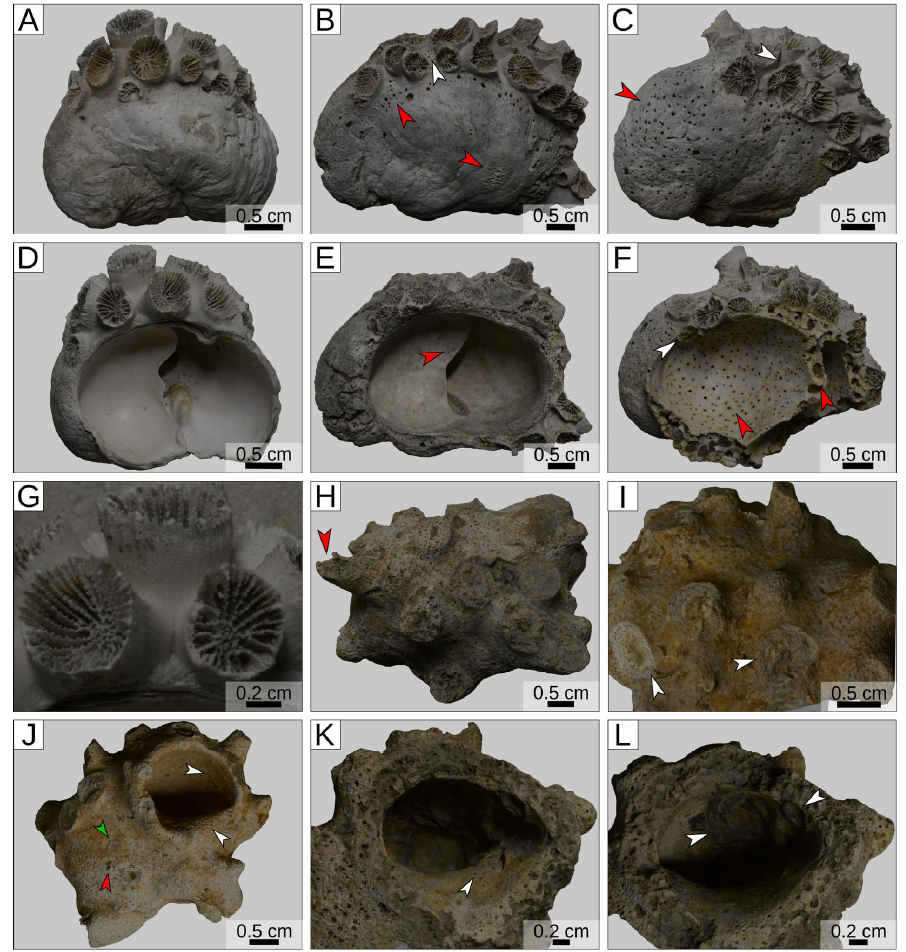
Figure 4. Pliocene specimens of Crepidula from the Yorktown Formation and hydractinian-encrusted gastropods form the Pliocene Pietrafitta outcrop. ( A ) Abapertural view of the best-preserved Crepidula specimen (MSNUP I-16955); ( B ) Abapertural view of the moderately preserved Crepidula specimen (MSNUP I-16956); white arrowhead indicates boreholes on the colony of Astrangia lineata ; red ar- rowheads indicate boreholes on the shell itself. ( C ) Abapertural view of the poorly preserved Crepidula specimen (MSNUP I-16957); white arrowhead indicates boreholes on the coral; red arrow- head indicates boreholes on the shell. ( D ) Apertural view of the best-preserved Crepidula specimen. ( E ) Apertural view of the moderately preserved Crepidula specimen; red arrowhead indicates bore- holes in the wall of the body chamber. ( F ) Apertural view of the poorly preserved Crepidula specimen; red arrowheads indicate boreholes on the shell; white arrowhead indicates A . lineata encrusting the inner surface of the body chamber. ( G ) Detail of corallites of A . lineata from the specimen depicted in panel ( A ). ( H ) Abapertural view of the least preserved hydractinian-encrusted gastropod from Pietrafitta (GAMPS 841); red arrowhead indicates one of the broken horn-like processes of the en- crusting calcareous hydrozoan. ( I ) Broken horn-like processes (white arrowheads) on the abapertural surface of the best-preserved specimen of hydractinian-encrusted gastropod from Pietrafitta (GAMPS 840). ( J ) Apertural view of the specimen depicted in panel ( J ); white arrowheads indicate the hydro- zoan encrustation extending deep into the body chamber; red arrowhead indicates the calcareous tube of a serpulid; green arrowhead indicates the basal plate of an acorn barnacle. ( K ) Apertural view of the same specimen as in panel ( H ); white arrowhead indicates boreholes on the inner surface of the body chamber, close to the aperture. ( L ) Apertural view of the same specimen as in panels ( H , K ) under different light conditions; white arrowhead indicates an oyster growing within the body